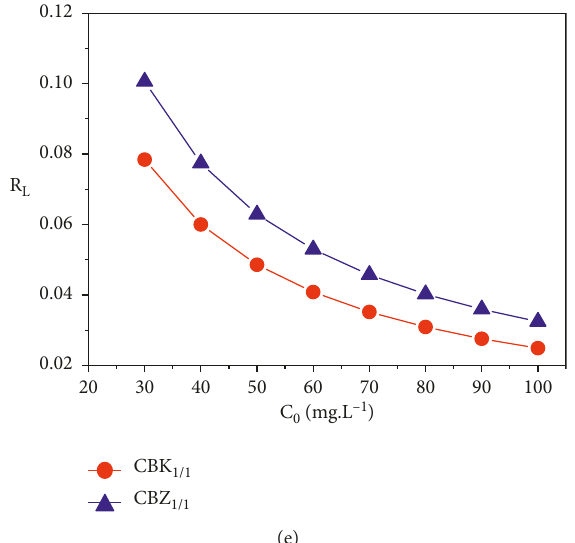
Figure 14: Linear regression of isotherm models of (a) Langmuir, (b) Freundlich, (c) Temkin, (d) Halsey, and (e) separation factor